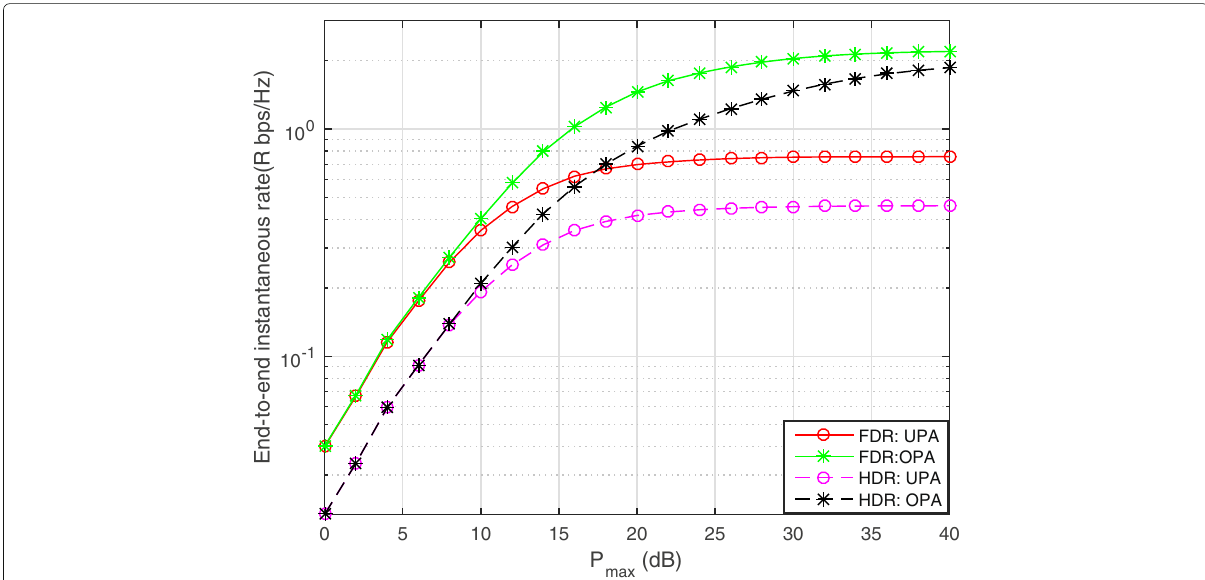
Fig. 7 End-to-end instantaneous rate comparison under UPA and OPA for FDR/HDR systems: m = 1, π 0 = 0.01, and N =